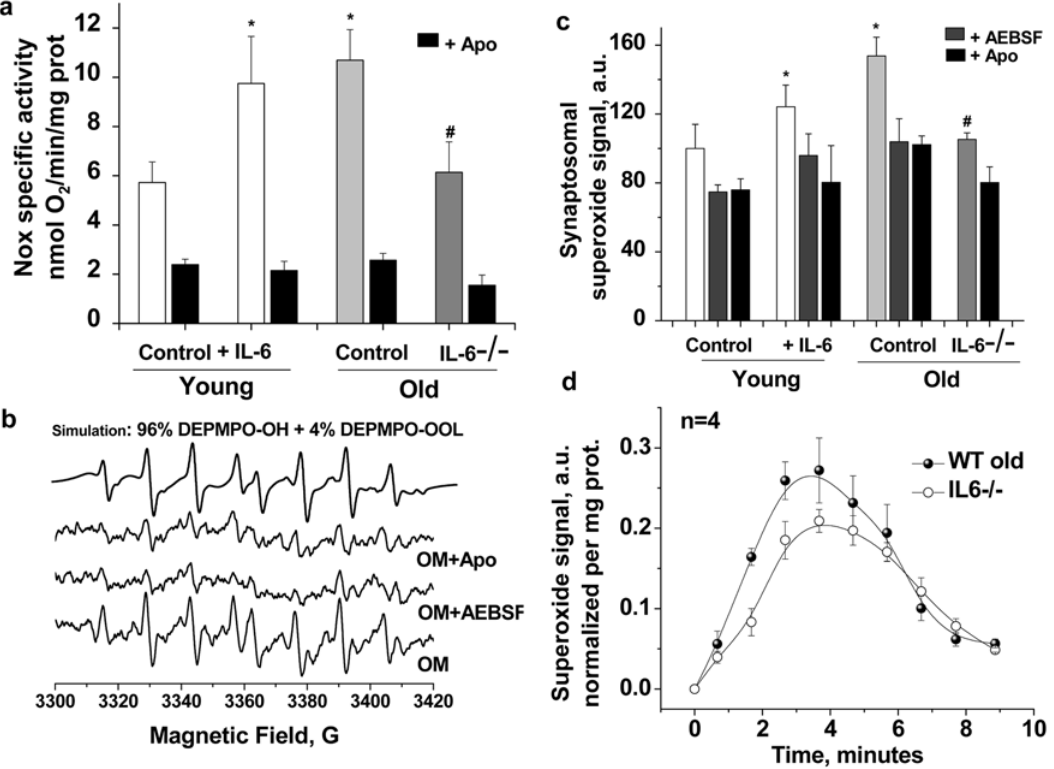
Figure 3. Increased synaptosomal Nox-2 activation and superoxide production in old wild-type mice is absent in old IL-6-/- mice; determination by electrochemical oxygen consumption analysis and EPR spin-trapping spectroscopy. (a) NADPH-induced oxygen consumption is significantly decreased by the Nox inhibitor apocynin (300 m M, black bars). Oxygen consumption by synaptosomal Nox from the cortex of young (3–4 M, n=9) and old (23–24 M, n=9) animals at 37 u C was induced by the addition of 5 mM NADPH to samples containing 2–5 mg synaptosomal protein. The observed Nox specific activity was significantly higher in IL-6 injected young animals (white bars, p=0.04, n=5) and in old brains (light gray bar, p=0.01, n=9) and was significantly lower in IL-6-/- old mice (dark gray bar, p=0.04, n=4). IL-6 treatment: Two IL-6 i.p. injections (5 mg/kg), separated by 12 hrs were administered to young and old animals before the groups were sacrificed 12 hrs later for synaptosomal isolation. (b) Representative EPR spectra recorded 3 minutes after mixing 5 mM NADPH with 0.2–0.5 mg synaptosomal protein isolated from brain of old mice at 37 u C with 70 mM DEPMPO in the absence or in the presence of 200 m M AEBSF or 300 m M apocynin. In each incubation, 10 mM DETC was included to inhibit the SOD enzyme, resulting in enhanced and quantifiable EPR signals. Using computer simulations we concluded that the observed signals are attributable to a mixture of adducts of DEPMPO with hydroxyl radical and lipid derived carbon centered radical and both radicals are derived from superoxide since the signals were completely abolished in the presence of SOD; not shown. (c) Quantification of the observed EPR signals accumulated over the first 3 minutes from NADPH addition, n=4–9 per group. Superoxide yield in synaptosomes isolated from different groups follows essentially the same activity pattern seen by oxygraphy and shown in (a). The asterisks (*) designate statistical significance by ANOVA followed by Tukey test with respect to young control while ( # ) indicate statistical significance with respect to old control. EPR settings are described fully in methods. Data are mean 6 SEM. (d) Nox-generated superoxide burst in synaptosomes isolated from IL-6-/- KO mice is significantly lower than that in their old control brains.